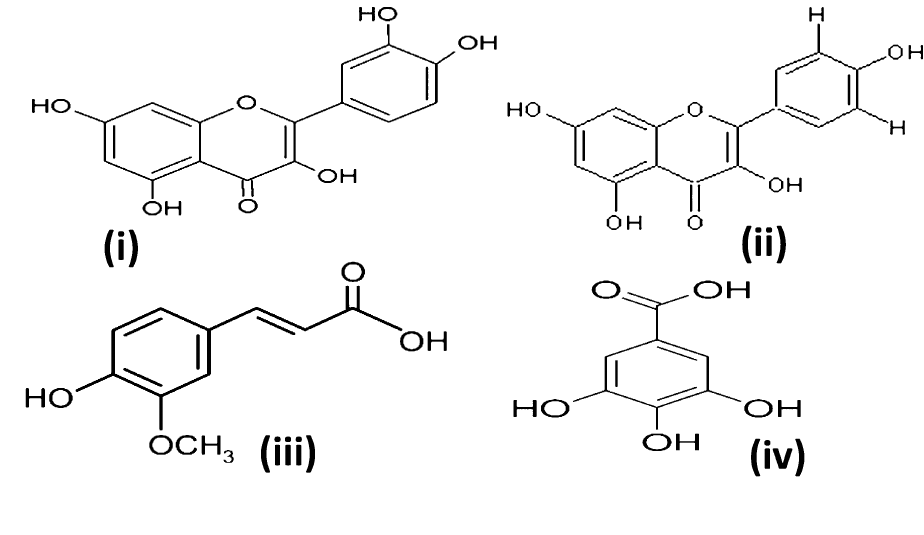
Fig. 1 Some major chemical compounds in Allium cepa extracts, namely (i) quercetin (ii) kaempferol (iii) ferulic acid and (iv) gallic